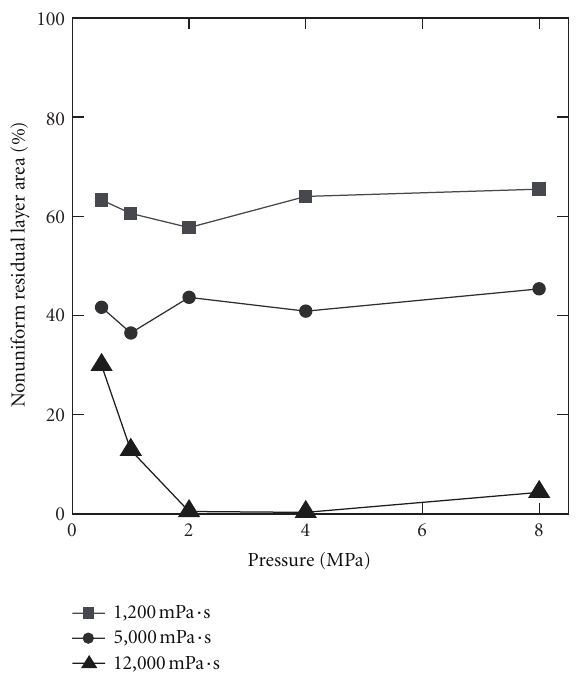
Figure 6: Relationship between nonuniformity of the residual layer and imprinting pressure: with low-viscosity resin, the fringe area did not depend on imprinting pressure; with high-viscosity resin, the fringe area was within 10% using an imprinting pressure ≥ 2MPa.